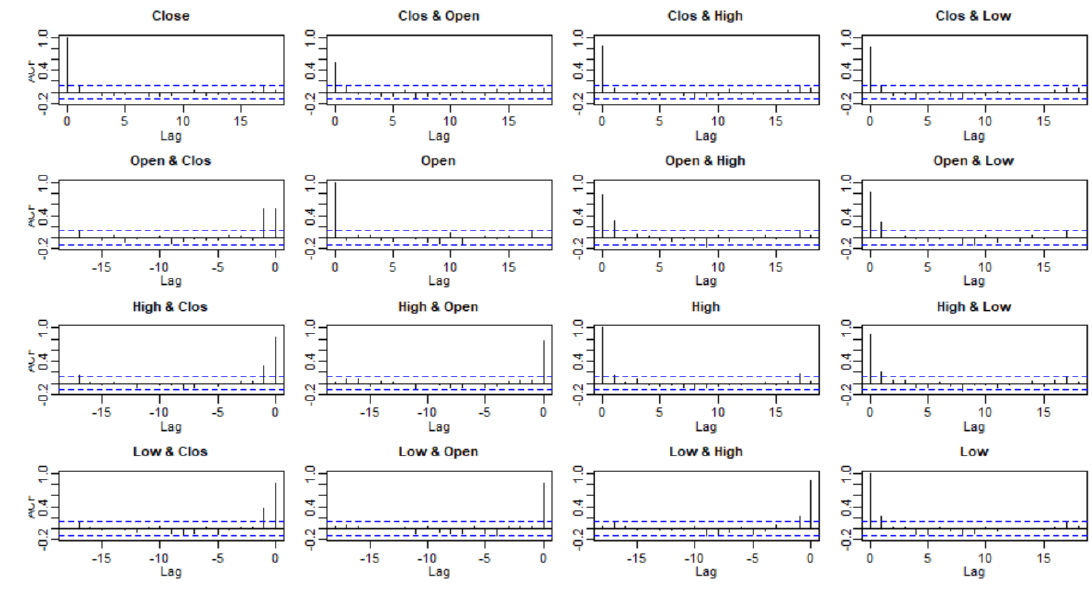
Figure A4. ACF test for correlation between open, low, high, and close of Google stock daily